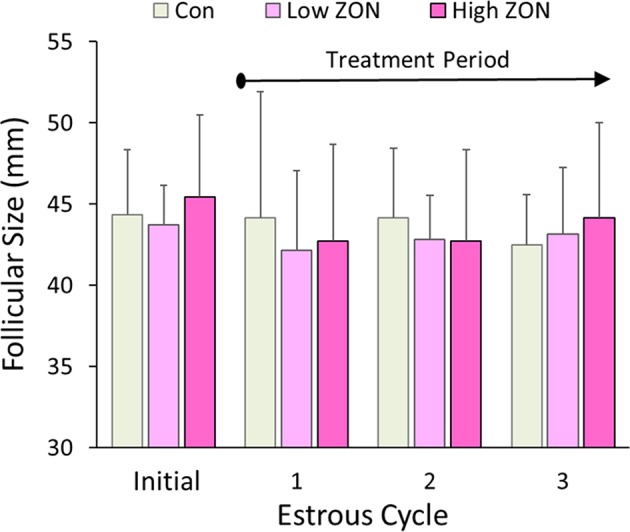
Dominant follicle size at ovulation within each of three estrous cycles with chronic ZON exposure compared to pre-exposure follicle size in cycle 0. Values are Means ± S.D.